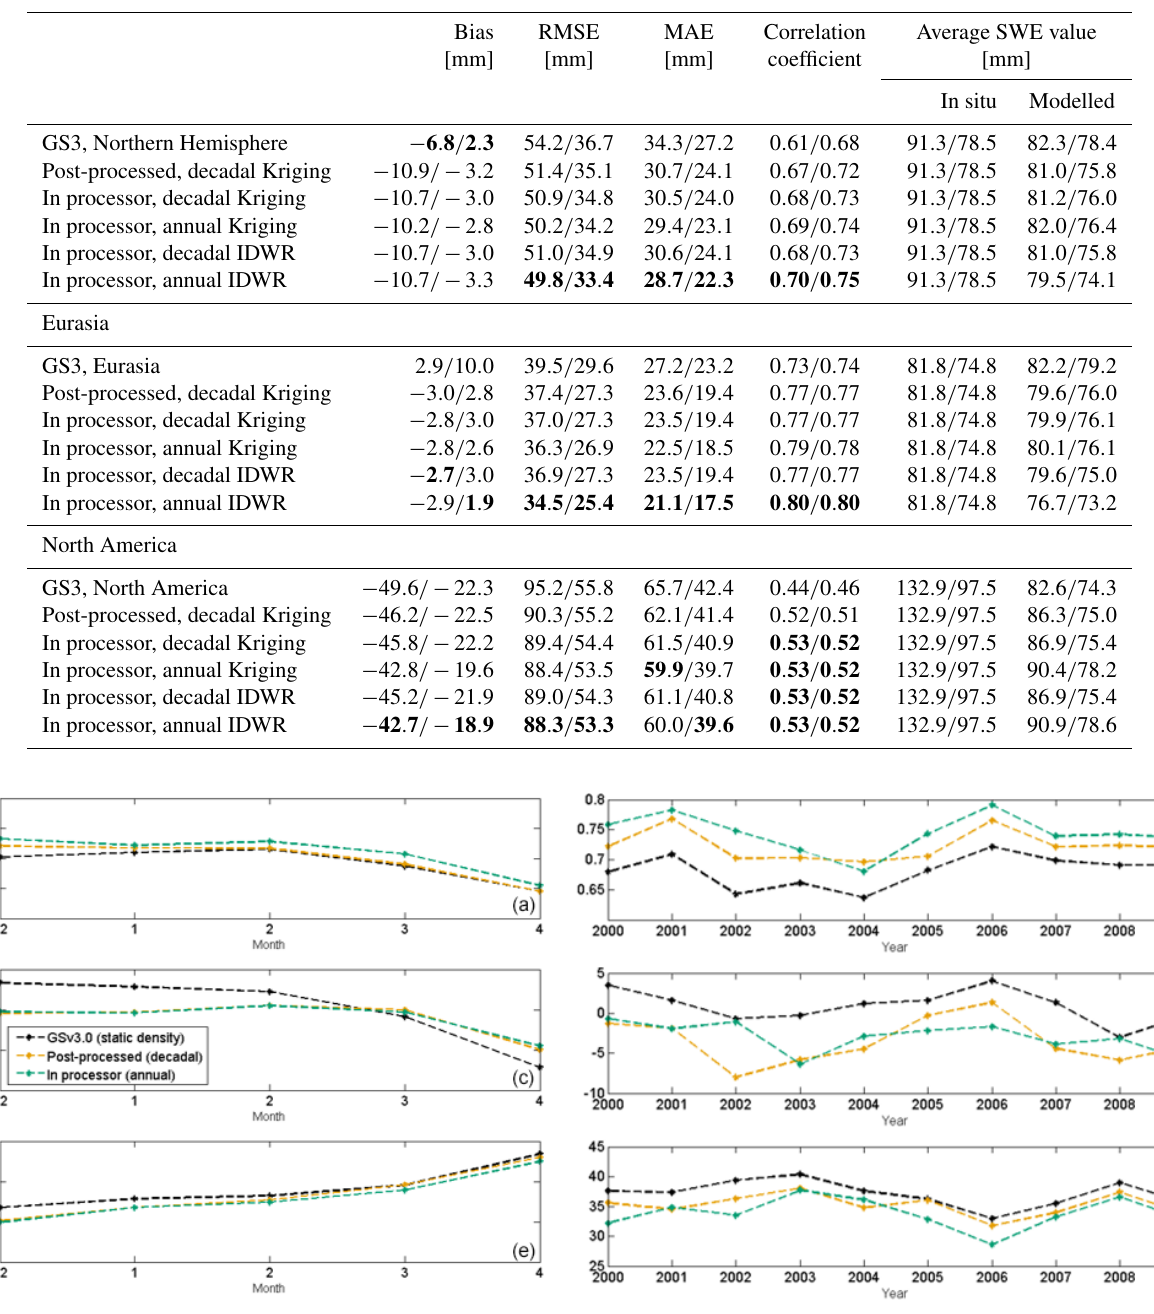
and the retrieval overestimates at the lower ranges of SWE (e.g. below ∼ 100 mm; see Fig. 8). Overall differences be- tween different products are smaller in Eurasia than in North America, and the largest differences occur in January (earlier months in the snow season not shown) and decrease as the